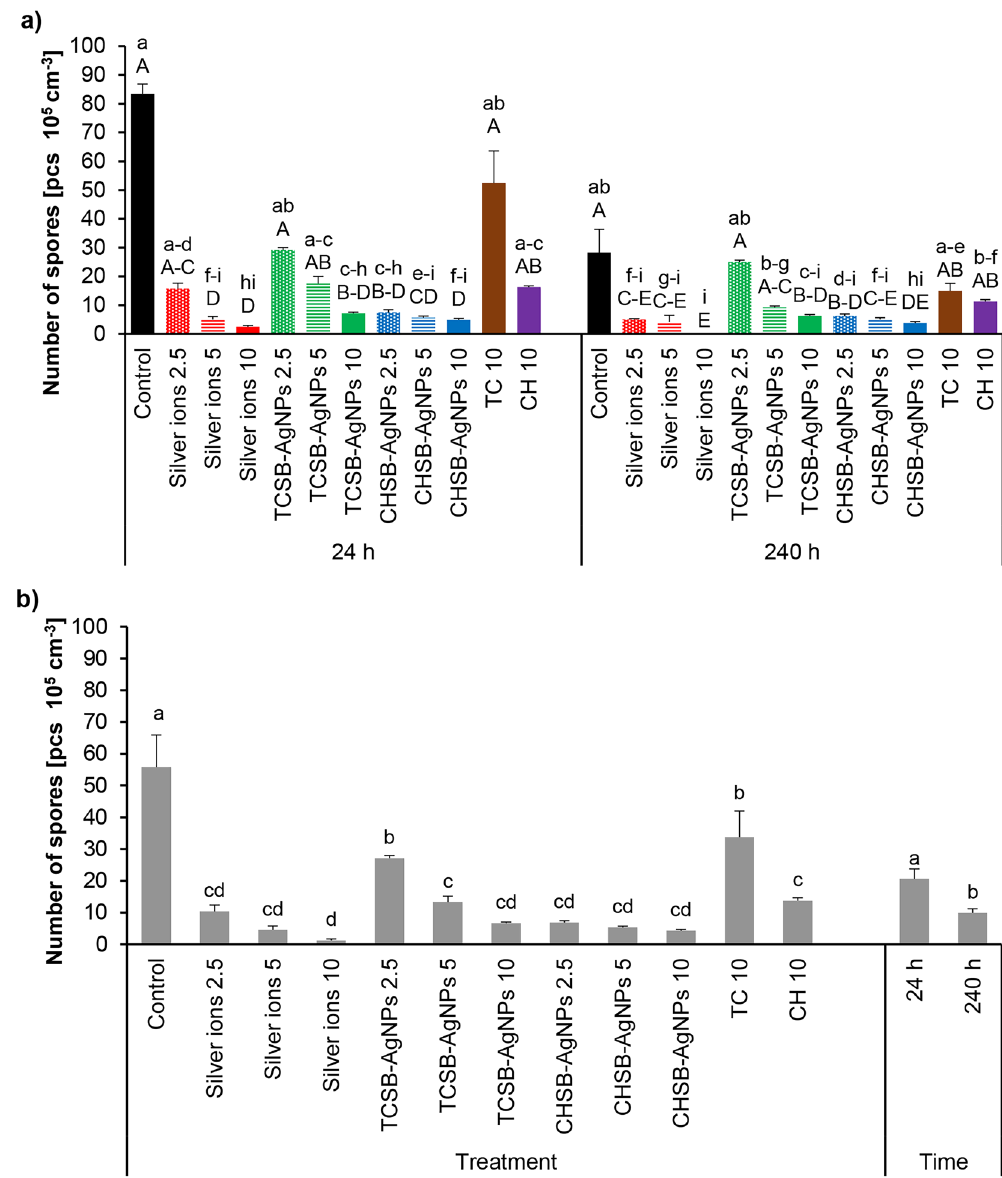
Figure 6. The impact of silver ions, AgNPs and stabilizing agents on the sporulation of F. equiseti after culture over 24 h and 240 h of the exposure period: factors interaction effect ( a ), factors effect ( b ). Data represents mean values ± SE. Values marked with the same letters (lowercase letters for the interaction effect, as well as the main effects of time and treatment; capital letters for interaction effect separately for the hours) are not significantly different at p ≤ 0.05. The number given for each treatment represents the concentration expressed in mg L −1